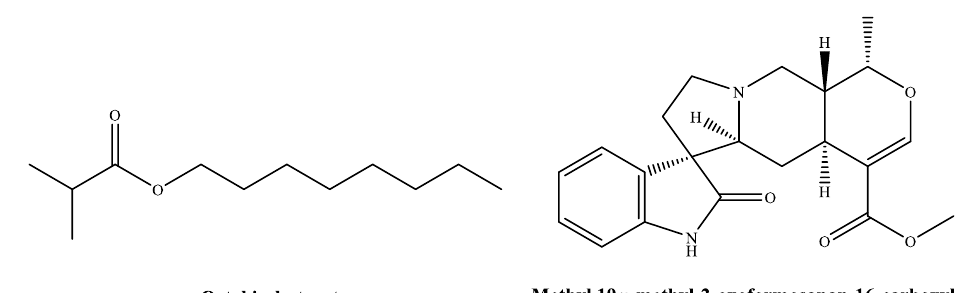
Figure 2. Main phytochemicals identified in Uncaria tomentosa bark extract.